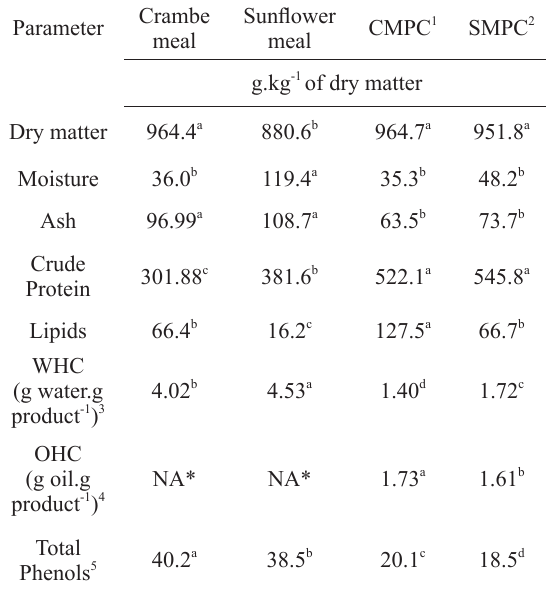
Chemical composition, functional properties and total phenols of the crambe and sunflower meals and the protein concentrates isolated from the meals using the isoelectric pH method.